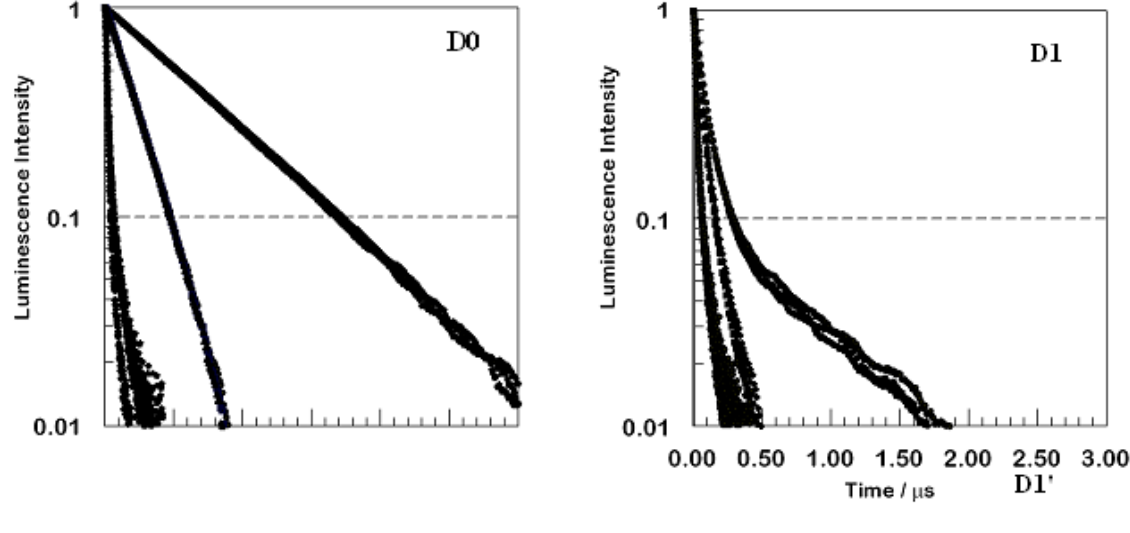
Figure 3. Comparison for two compounds, D0 and D1 , of time-resolved luminescence from argon-sparged methanolic solution (top set of curves in each panel), from the same solutions equilibrated with air (middle set of curves), and from thin films (lowest and fastest decaying set of curves). Excitation wavelength was 355